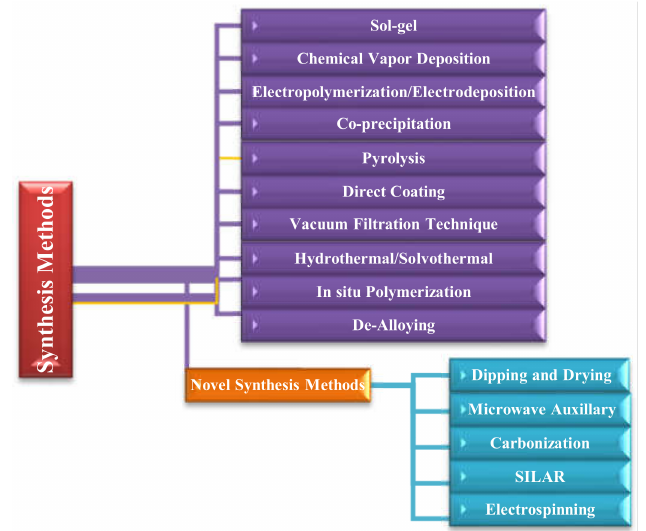
Figure 5. Different electrode material synthesis methods for